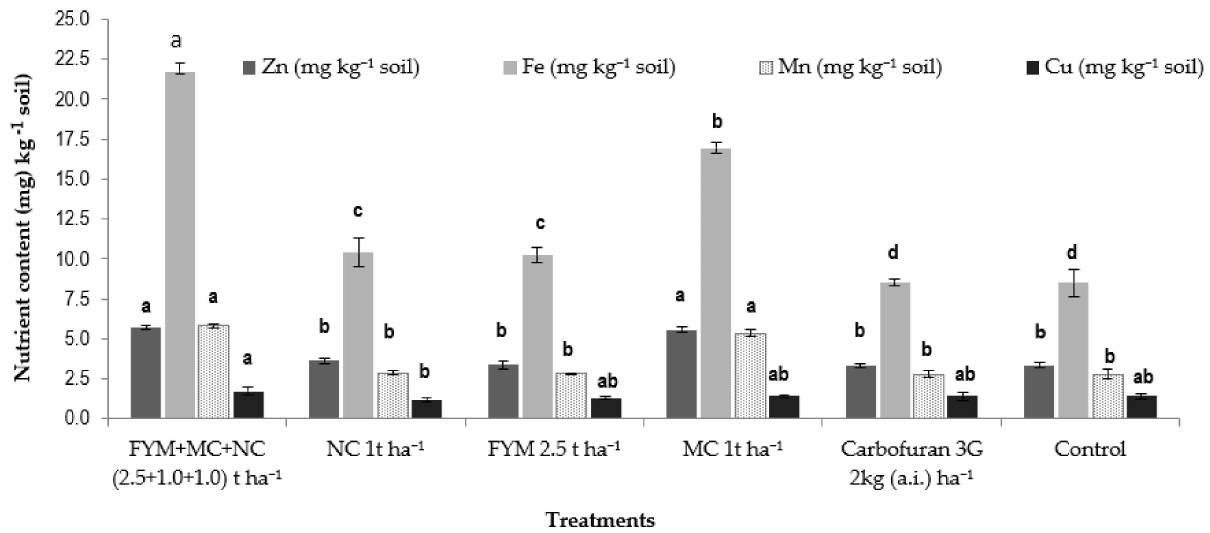
Figure 2. Effect of different amendments on micronutrient composition of the soil (polyhouse-I). The columns show the mean value of three replicates and the bars show the standard error of means. The columns labelled with different letters are significantly different according to the LSD test at 5% probability. MC = mustard cake; NC = neem cake; FYM = farmyard